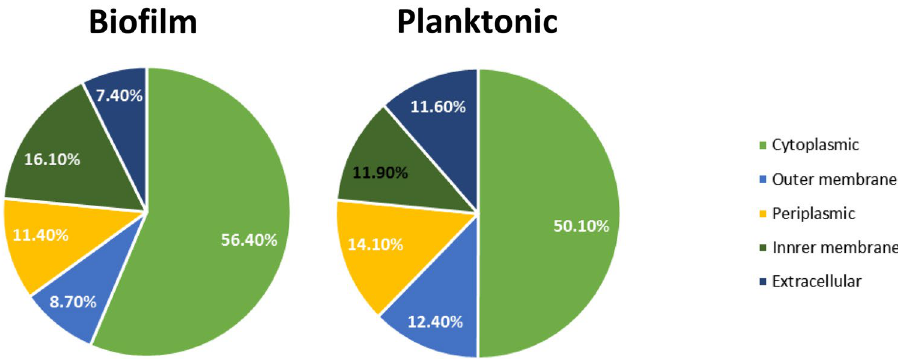
Figure 2. Subcellular localization of proteins. Protein FASTA sequences were analyzed for their subcellular localization using the bioinformatics tool CELLO2GO. The results obtained were compared with other predictions tools such as PSORTb and